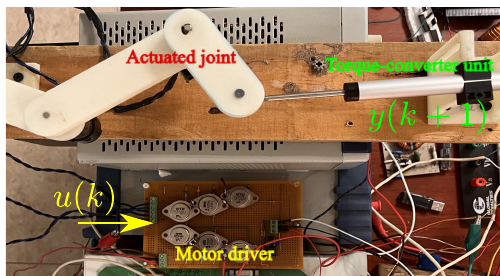
Figure 1. Experimental system.